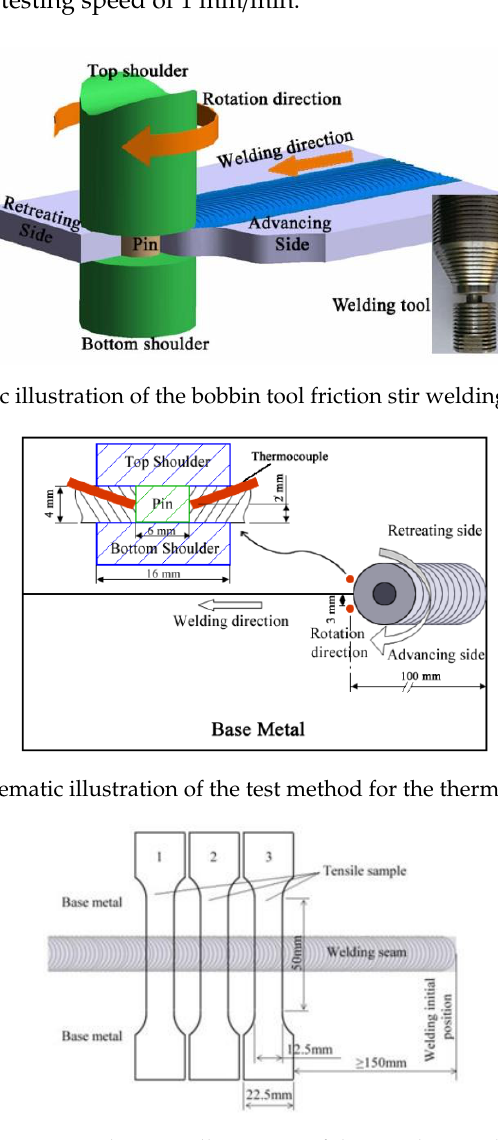
Figure 3. Schematic illustration of the tensile sample.